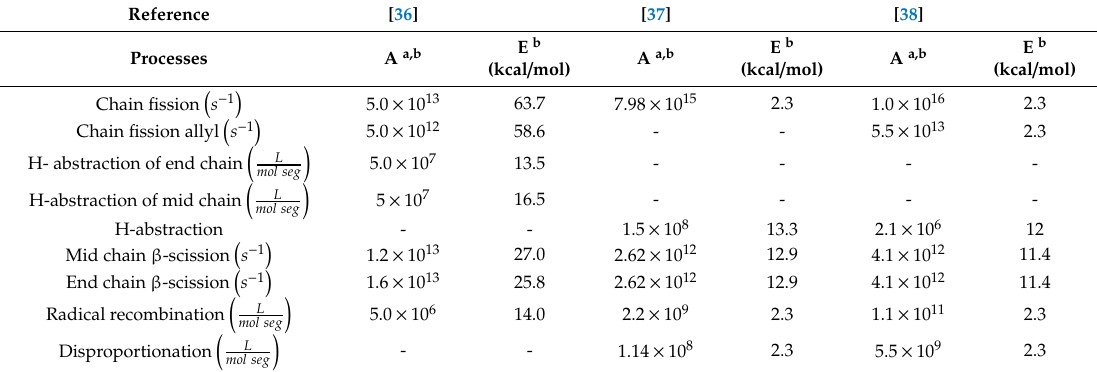
Table 4. Reaction kinetic constants of polystyrene depolymerization from literature